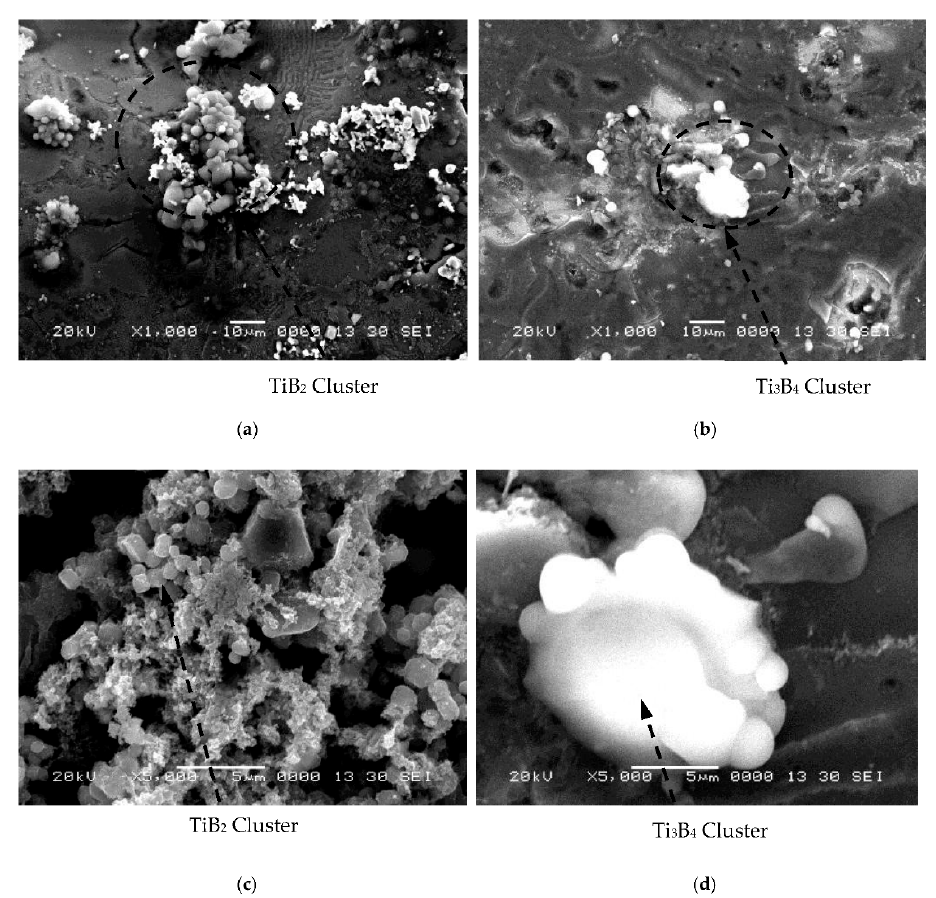
Figure 5. Magnified image of clusters of (Figure 3) by SEM shows segregation of TiB 2 ( a , c ) for 20 min and particles and Ti 3 B 4 ( b , d ) for 50 min.